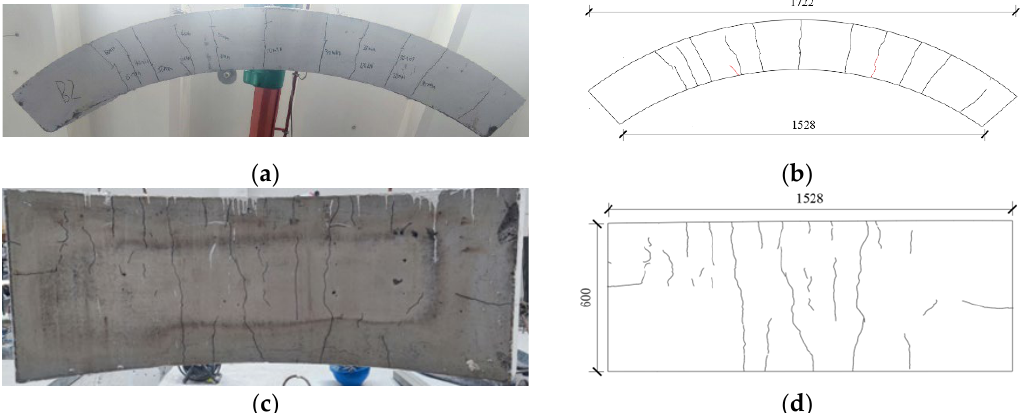
Figure 8. Failure modes of Segment RC—2: ( a ) Cracking pattern; ( b ) Crack pattern on the side surface; ( c ) Bottom surface; and ( d ) Cracking pattern on the bottom surface.